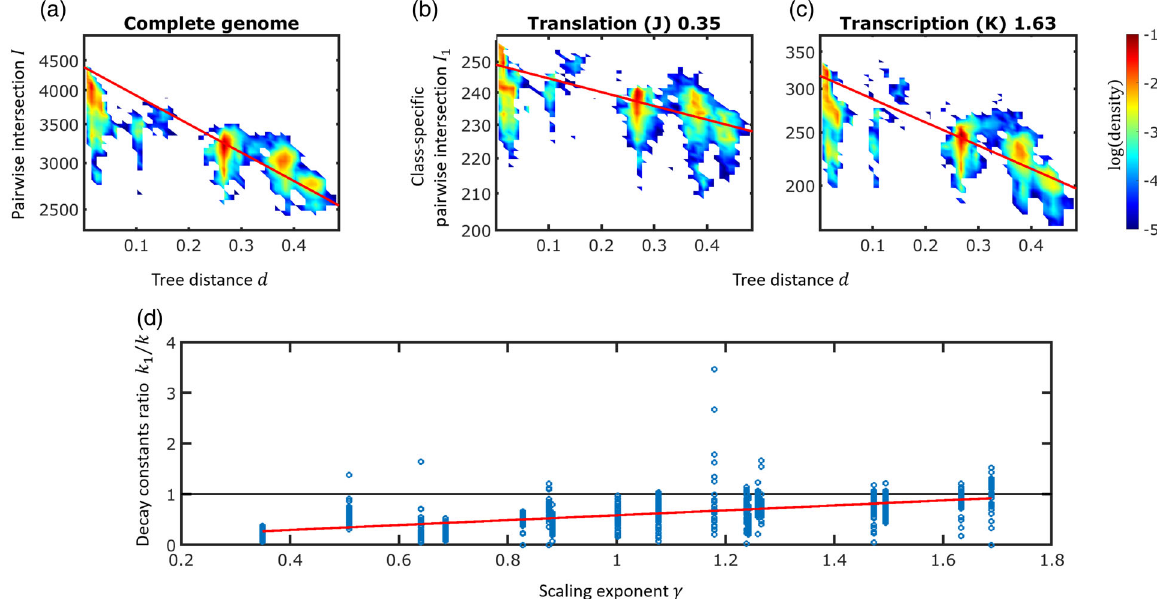
FIG. 6. Decay of prokaryotic gene content similarity with tree distance. The figure illustrates the agreement between the model prediction of the exponential decay of the pairwise intersections between genomes with the evolutionary distance with the genomic data. (a) The pairwise intersection between genomes I plotted against the tree distance d for complete genomes of E. coli . Intersections are calculated across all pairs of genomes in the ATGC, and the colors represent the point density where each pair of genomes is represented by a point ( n ¼ 93 , 096). The exponential decay fit of Eq. (14) is shown by the red solid line. (b) Pairwise intersections between genomes for translation genes (J) from the E. coli genomes. Intersections are calculated for all pairs of genomes in the ATGC, and the colors represent the point density where each pair of genomes is represented by a point. The exponential decay fit of Eq. (16) is shown by the red solid line. (c) Same as (b) for transcription genes (K). (d) Scatter plot showing the class-specific decay constant normalized by the genomewide decay constant vs the scaling exponents of the different functional classes. A linear fit is shown by the red line. Defense genes (V) and the mobilome (X) deviate from the typical values and are excluded from the